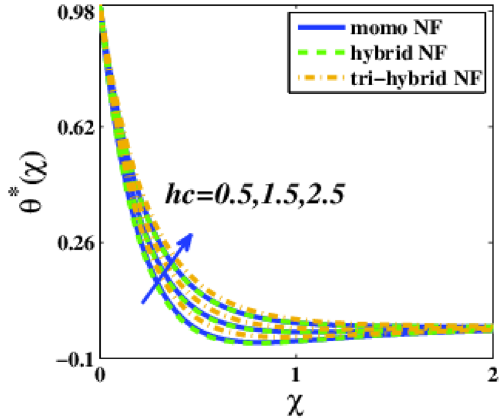
Figure 23. Bearing of hc on θ ∗ (χ) .